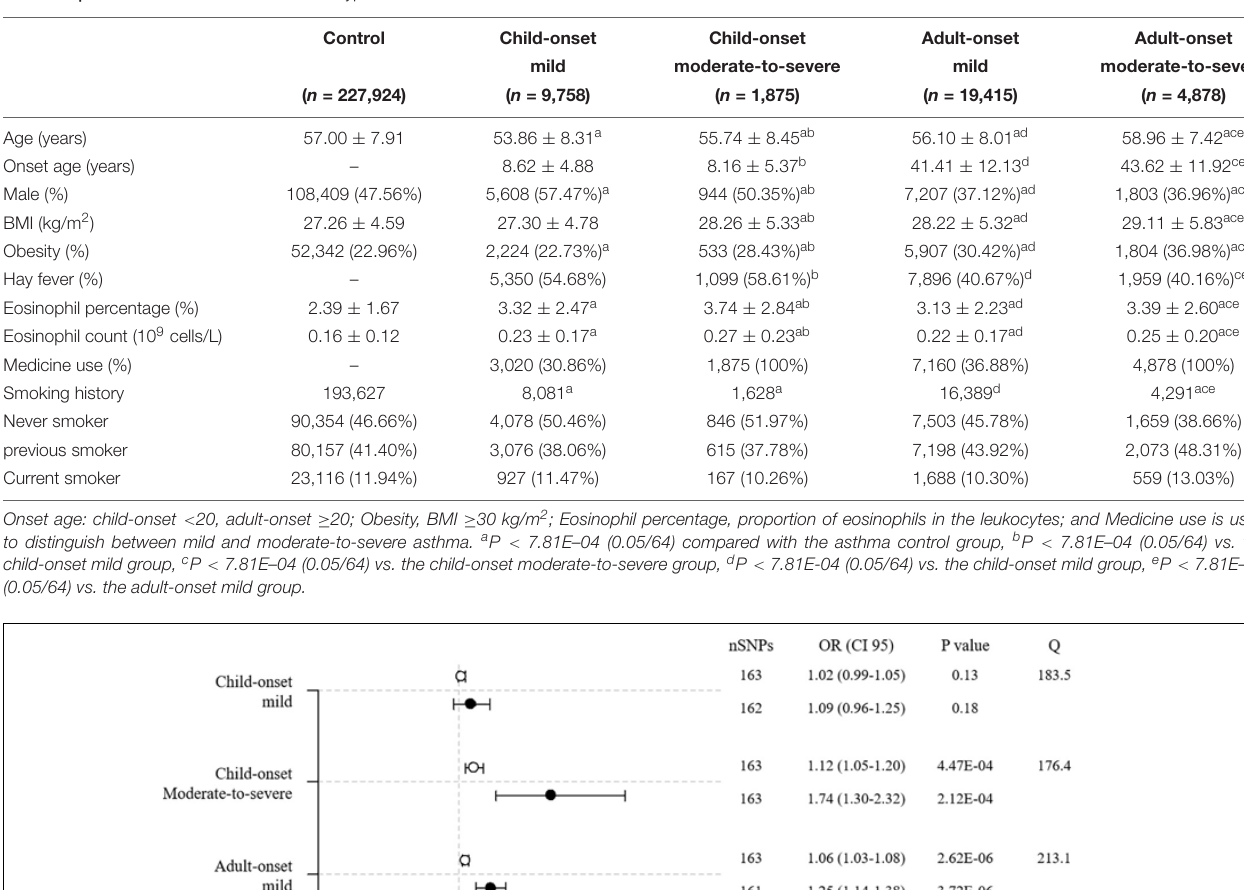
TABLE 2 | Characteristics of the asthma subtypes and controls from the UK Biobank.